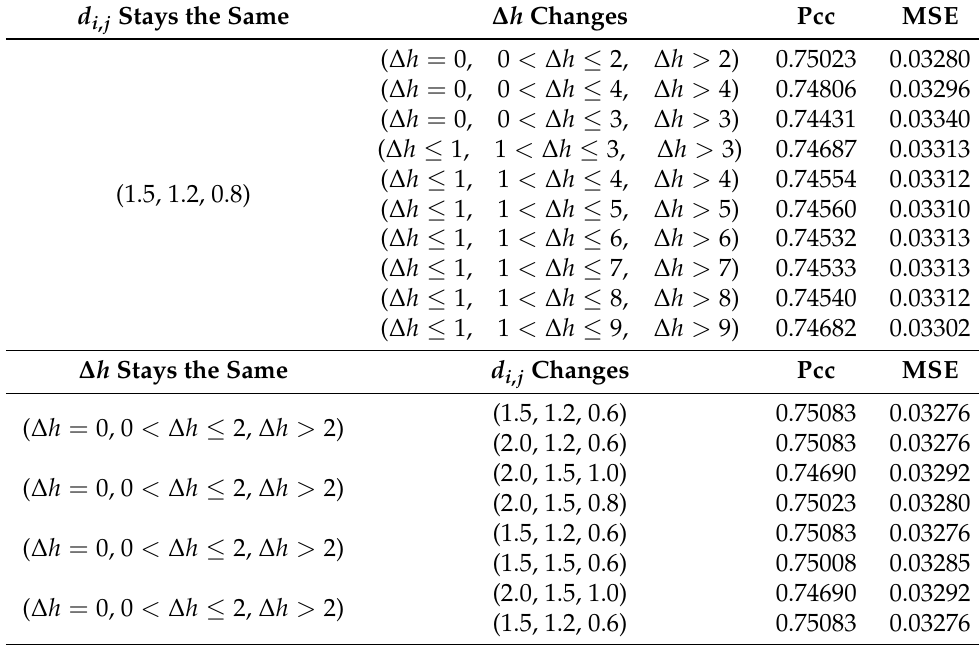
Table 9. Influence of parameters p h and ∆ h on sentence semantics of STS’14.deft-news.txt with